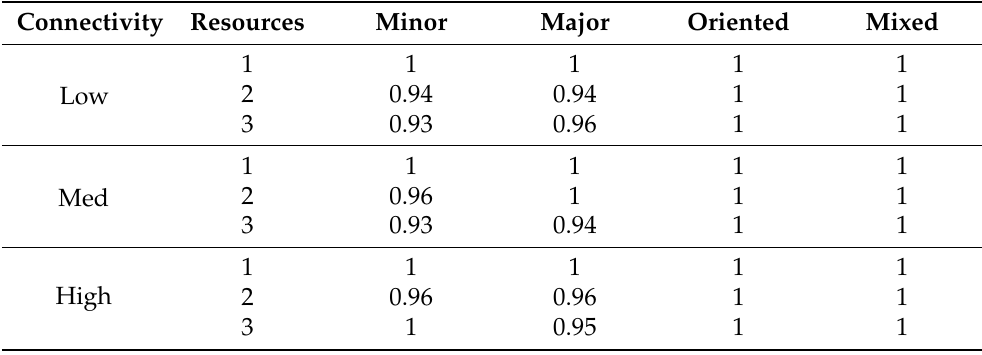
Table 3. Initial results: ratio to optimal solutions. Connectivity